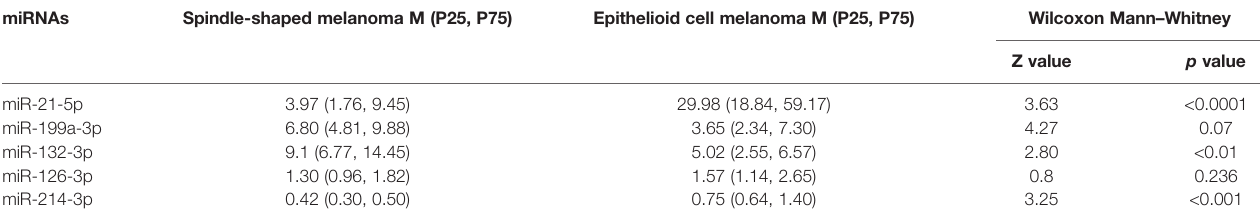
TABLE 5 | The normalized serum levels of miRNAs in spindle-shaped melanoma and epithelioid cell melanoma. miRNAs Spindle-shaped melanoma M (P25,